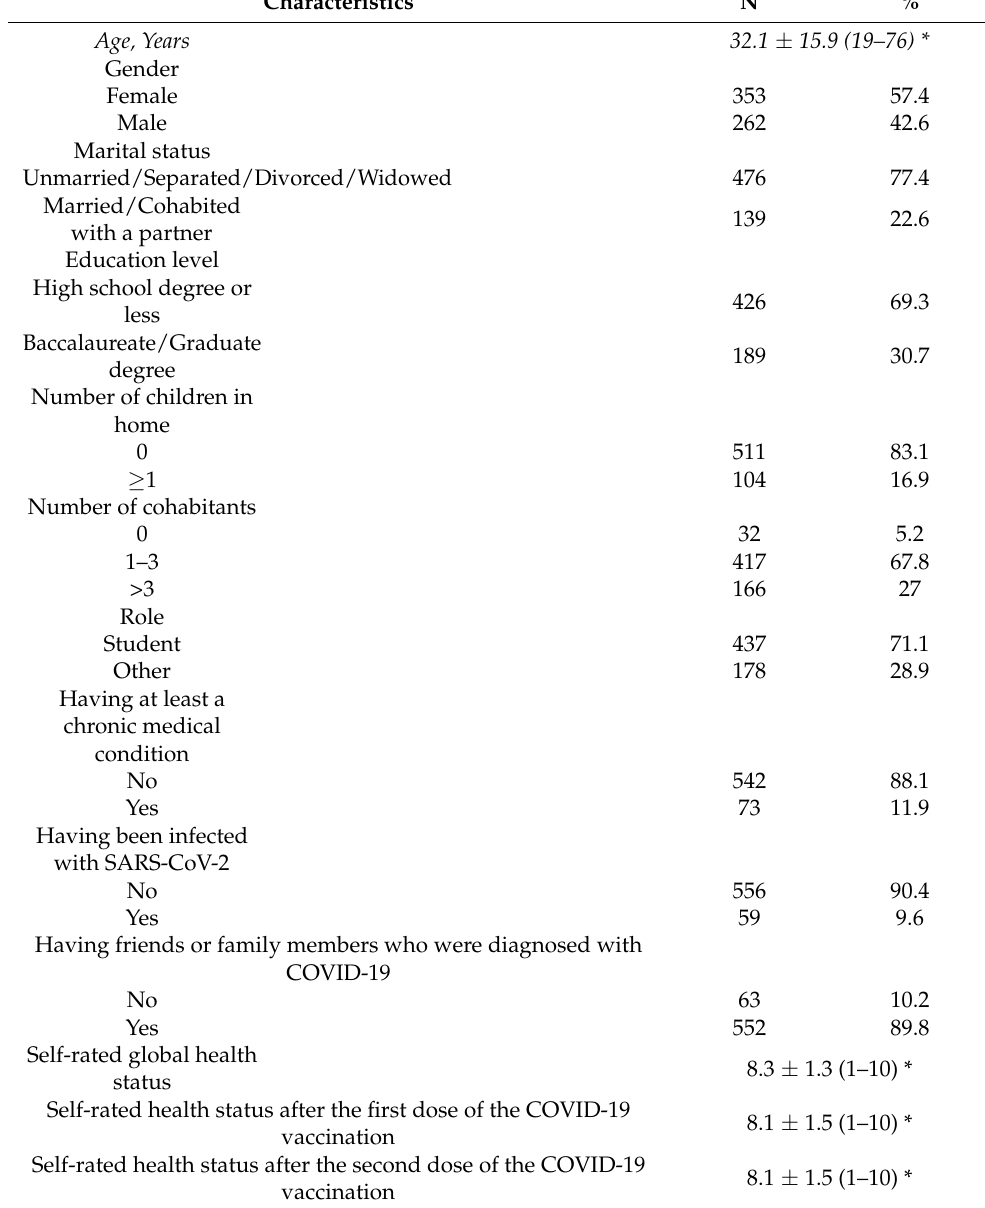
Table 1. Socio-demographic and key characteristics of the study